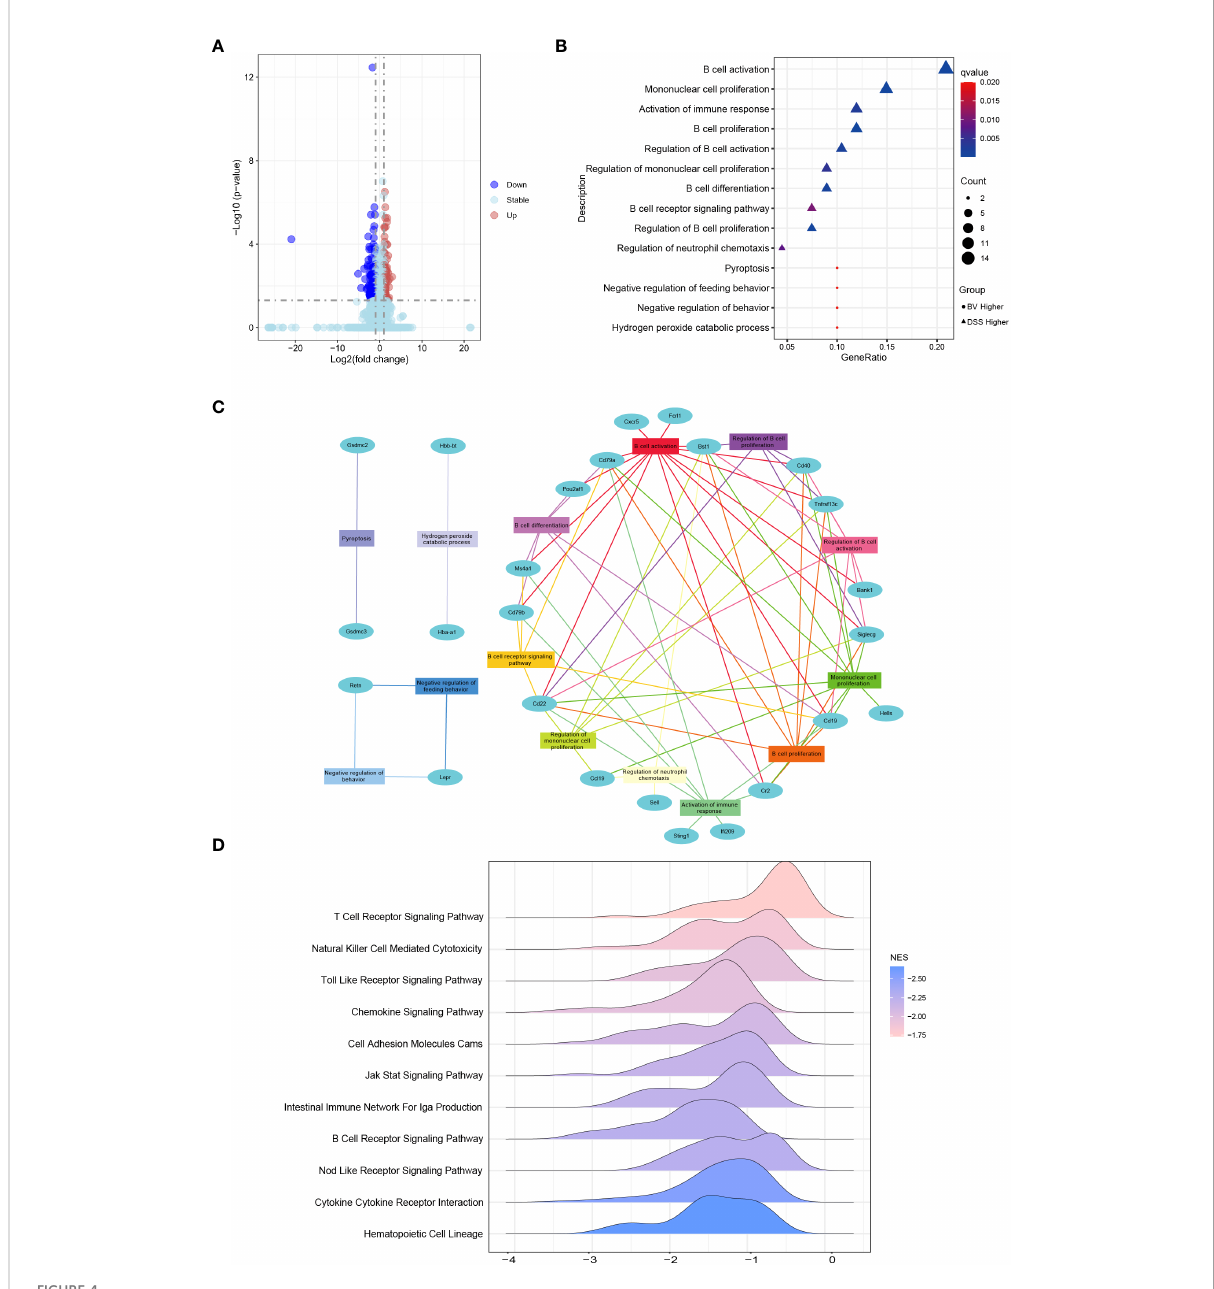
FIGURE 4 Effects of B. vulgatus Bv46 on transcriptome pro fi ling and functional analysis under the IBD setting. CT, DSS, and BV denote control (no DSS induction), DSS induction and treatment with phosphate buffer saline only, and DSS induction and treatment with B. vulgatus Bv46 respectively. (A) Volcano plots analysis for the distribution of colonic differentially expressed genes (DEGs) between the BV and DSS groups. (B) Functional enrichment analysis of colonic DEGs in the BV vs DSS groups. GO biological processes enriched in the up-regulated and down-regulated DEGs are plotted in triangle and circle, respectively. (C) Network analysis of colonic DEGs and the enriched GO biological processes. (D) B.vulgatus Bv46 induced changes of immune related KEGG pathways identi fi ed by the gene set enrichment analysis (GSEA) in colons. The distribution of core enriched genes was plotted based on fold changes on the horizontal